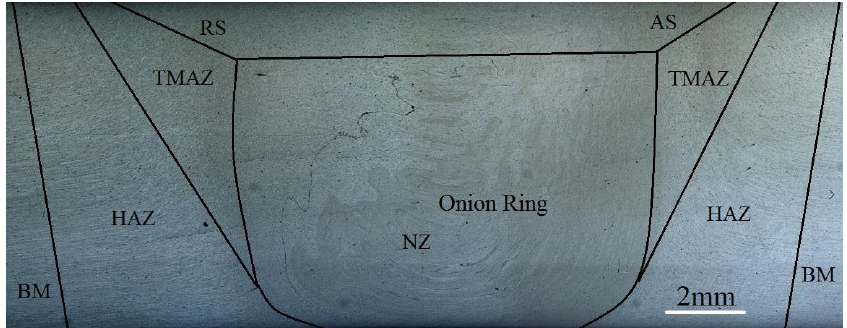
Figure 4. Macro-structure of FSWed joint (TMAZ: thermo-mechanically affected zone; HAZ: heat- Figure affected zone; BM: base metal).